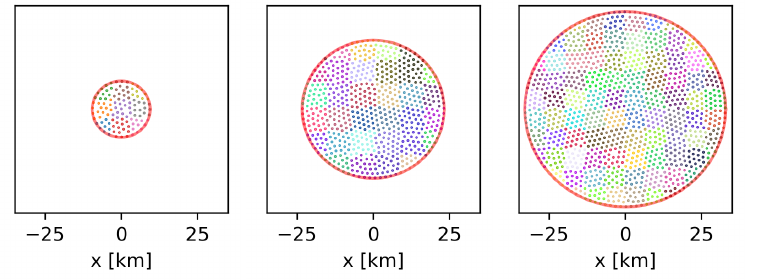
Figure 7. Hub layout ( left ) 2 GW ( center ) 12 GW ( right ) 24 GW. Each sub-farm is shown in different